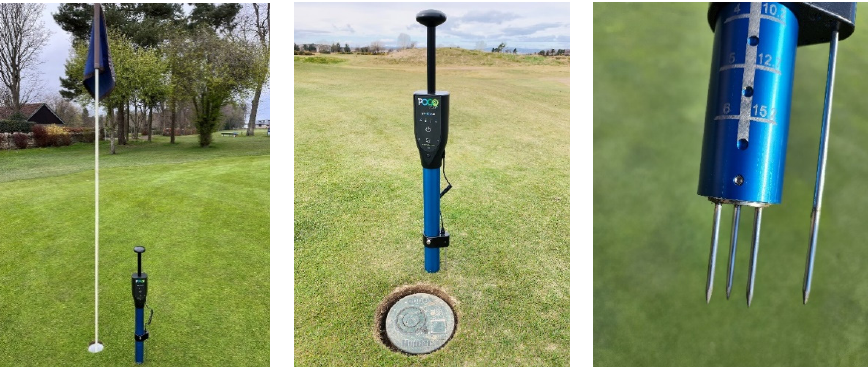
Figure 1. The POGO TurfPro (Stevens Water Monitoring Systems; Portland, OR, USA) is a portable device equipped with 5.6 cm metal rods that measures soil volumetric water content to the 5.71 cm depth. The extended metal rod at right side of device measures soil temperature.